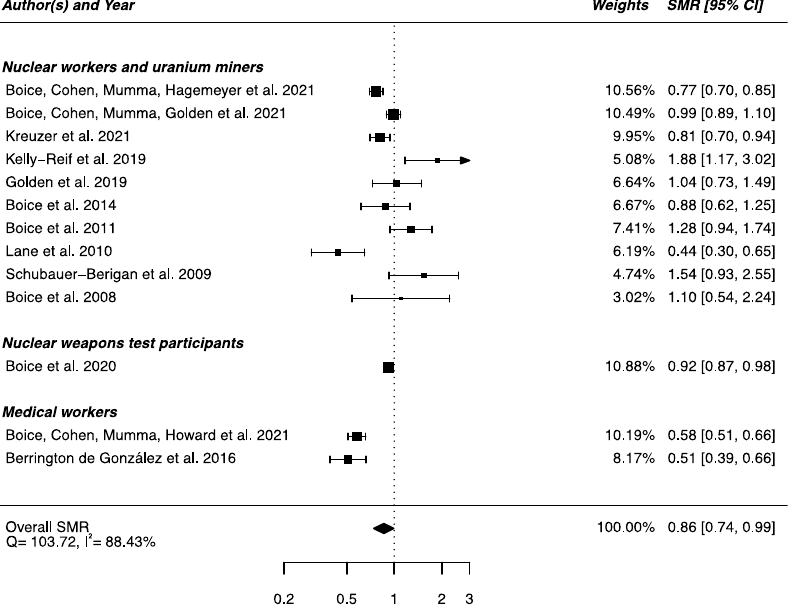
Figure 11. Standardized mortality ratio (SMR) and 95% confidence interval (CI) for mortality from mental and behavioral disorders in IR exposed populations compared with general populations as